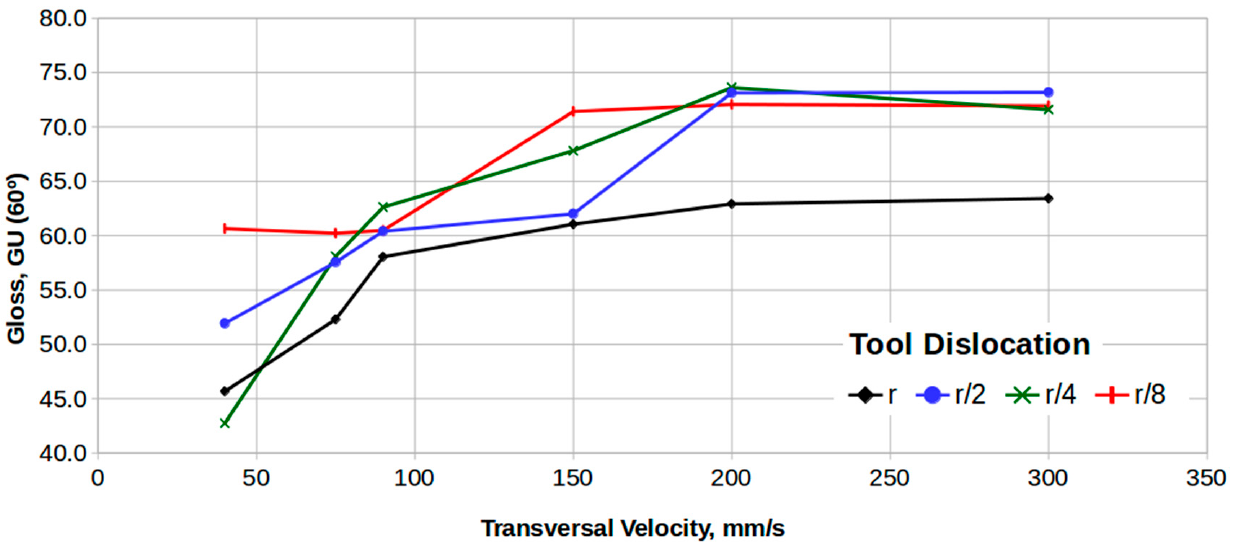
and rotational speeds) does not lead to a refinement of the surface quality.